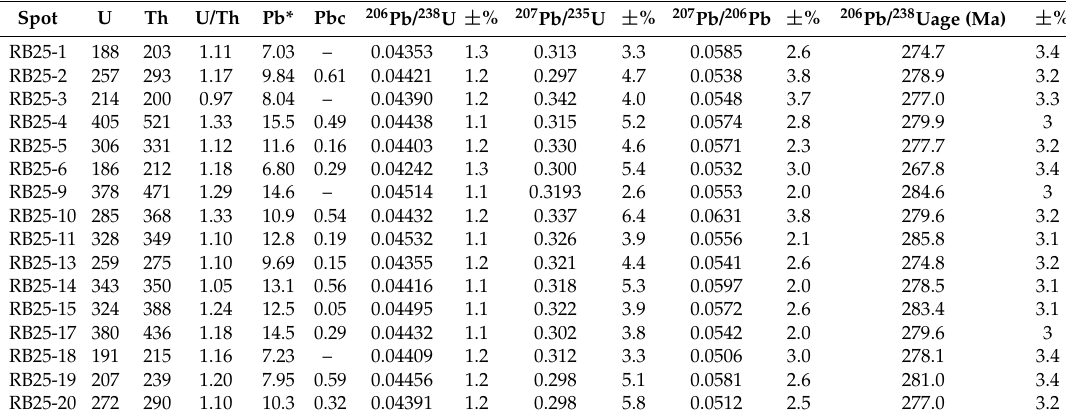
Table A1. SHRIMP zircon U–Pb isotope data for the Haoyaoerhudong gabbro. Spot